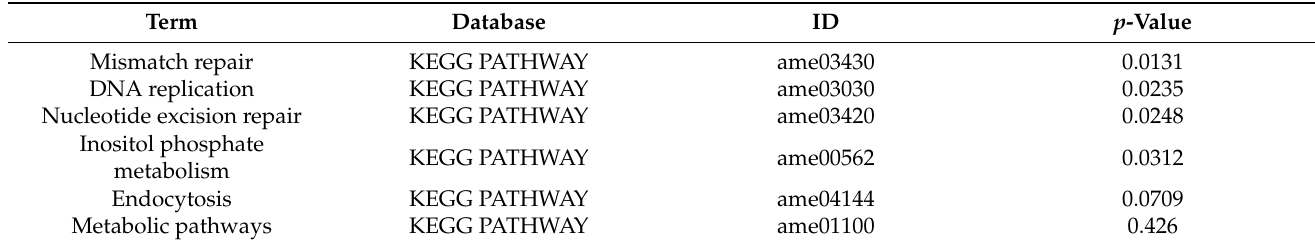
Table 3. KEGG enrichment analysis of genes under selection of Method